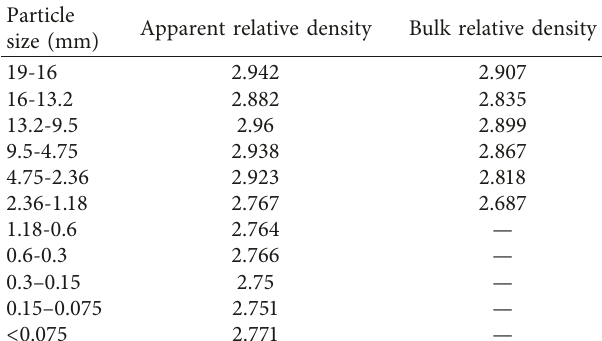
Table 5: Densities of the aggregates.